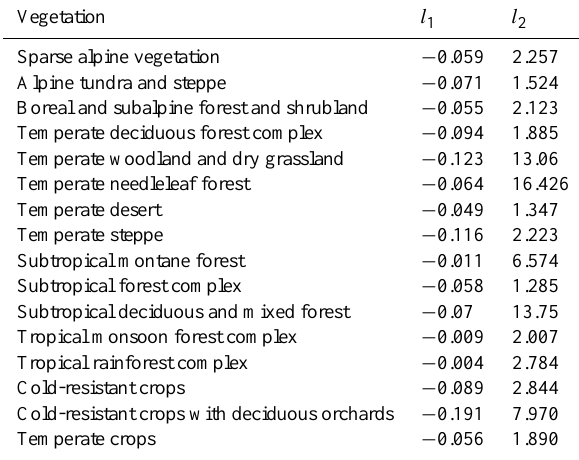
Table 3. Parameters used in Eq. (3) for each vegetation